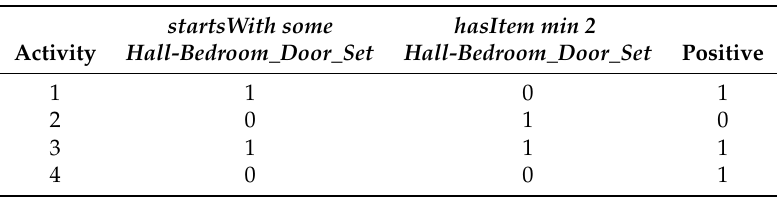
Table 2. Example of the resultant